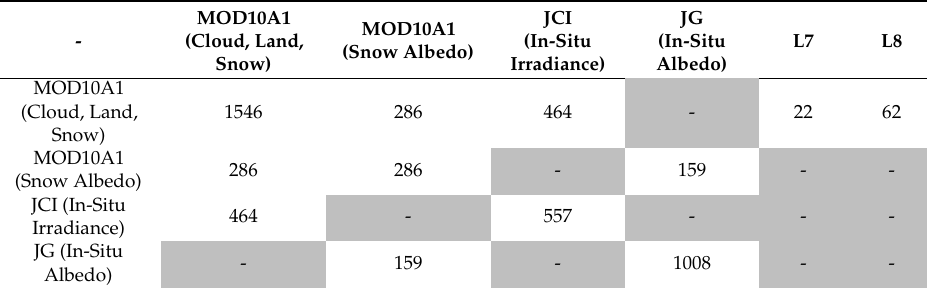
Table 1. Number of days with MOD10A1 (V005), Landsat, and in-situ data from December 1 2006 to February 11 2015. MOD10A1 data corresponds to the pixel where JG is located. For each season, only dates from September 1 until April 10 are considered (December 1 to April 10 for the 2006–2007 season and from September 1 to February 11 in 2014–2015 season). JCI, automatic weather station (AWS) at Juan Carlos I station (in-situ di ff use and global irradiances); JG = AWS at Johnsons Glacier (in-situ albedo). Shaded cells indicate data that have not been crossed.